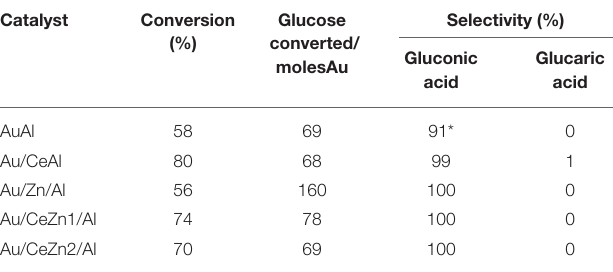
TABLE 3 | Conversion and selectivity values obtained over Au/CeO 2 -ZnO/Al 2 O 3